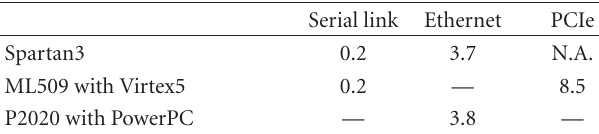
Table 5: Framerate of the JPEG codec on 3 platforms with 3 interfaces and a 512 × 512 video